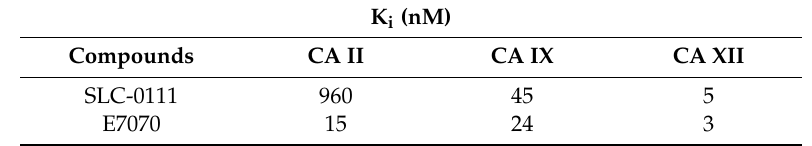
Figure 5. Surface representation of SLC-0111 (cyan) and E7070 (green) superimposed in the CA IX-mimic active site. Zinc is represented as a magenta sphere. Table 2. Binding constants for SLC-0111 and E7070 with CA II, CA IX, and CA XII.